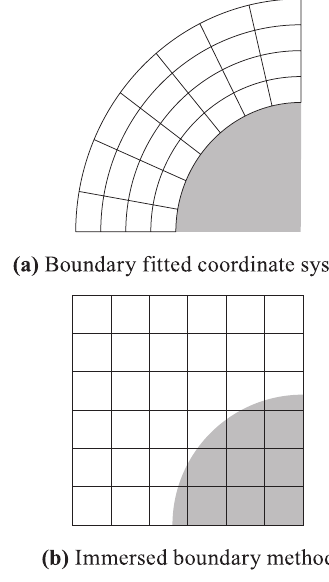
Fig. 1 Overview of typical computational grid